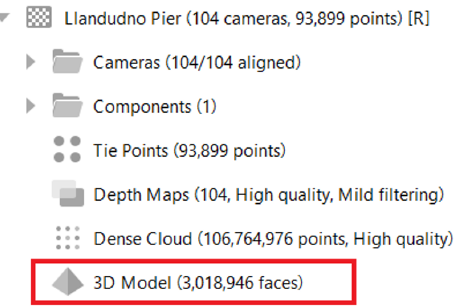
Figure A2. Number of triangles in the generated mesh (Agisoft